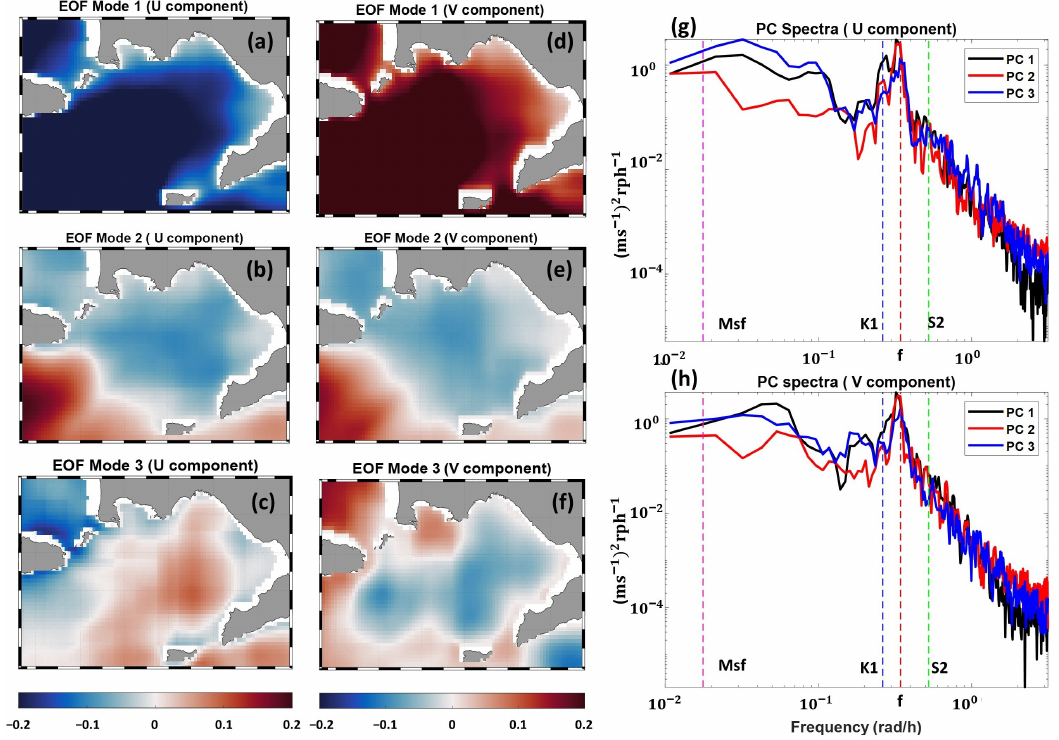
Figure 14. Spatial pattern of 3 EOF modes ( a – f ) for the simulated surface current field in April 2016. Frequency spectra of the expansion coefficient associated with the 3 principal modes for the zonal ( g ) and meridional ( h ) components.